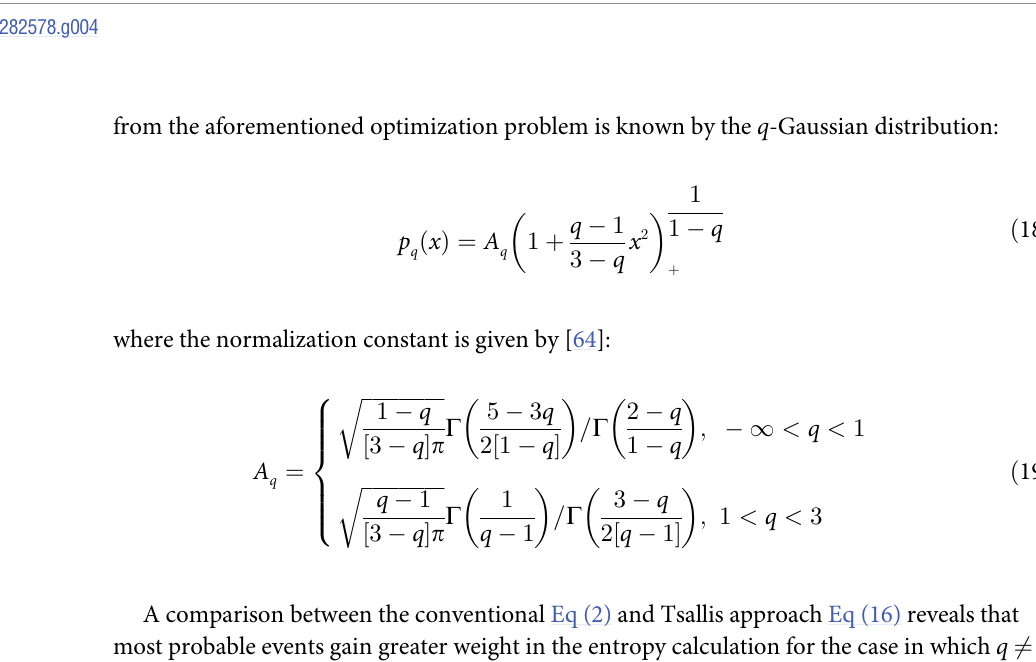
Fig 4. q -Gaussian probability distribution. The black dashed line represents the conventional